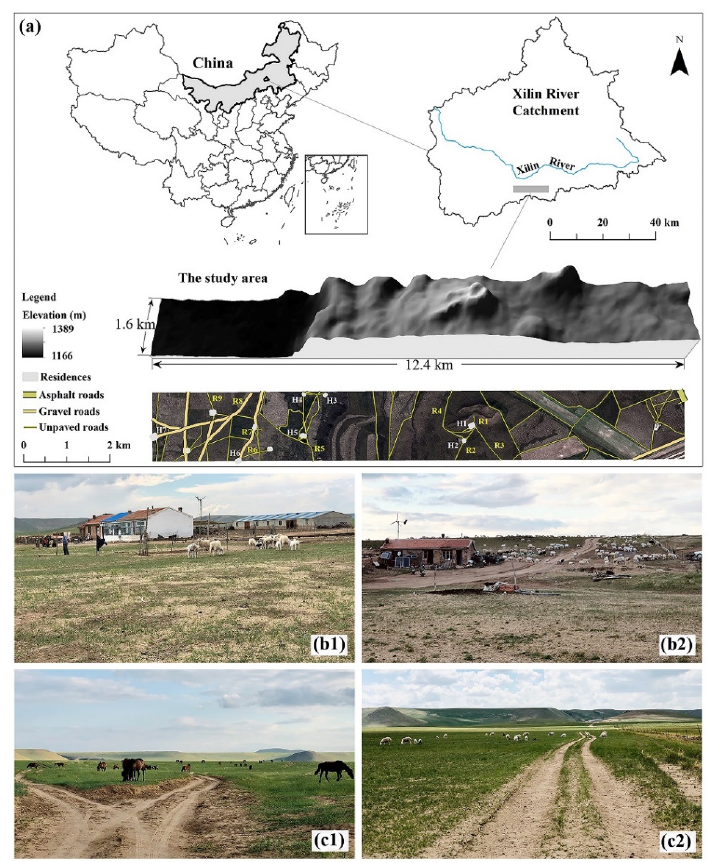
Figure 1. The location, topography, distribution of residences and roads (a), and eroded sites around residences (b) and unpaved roads (c) in the study area.